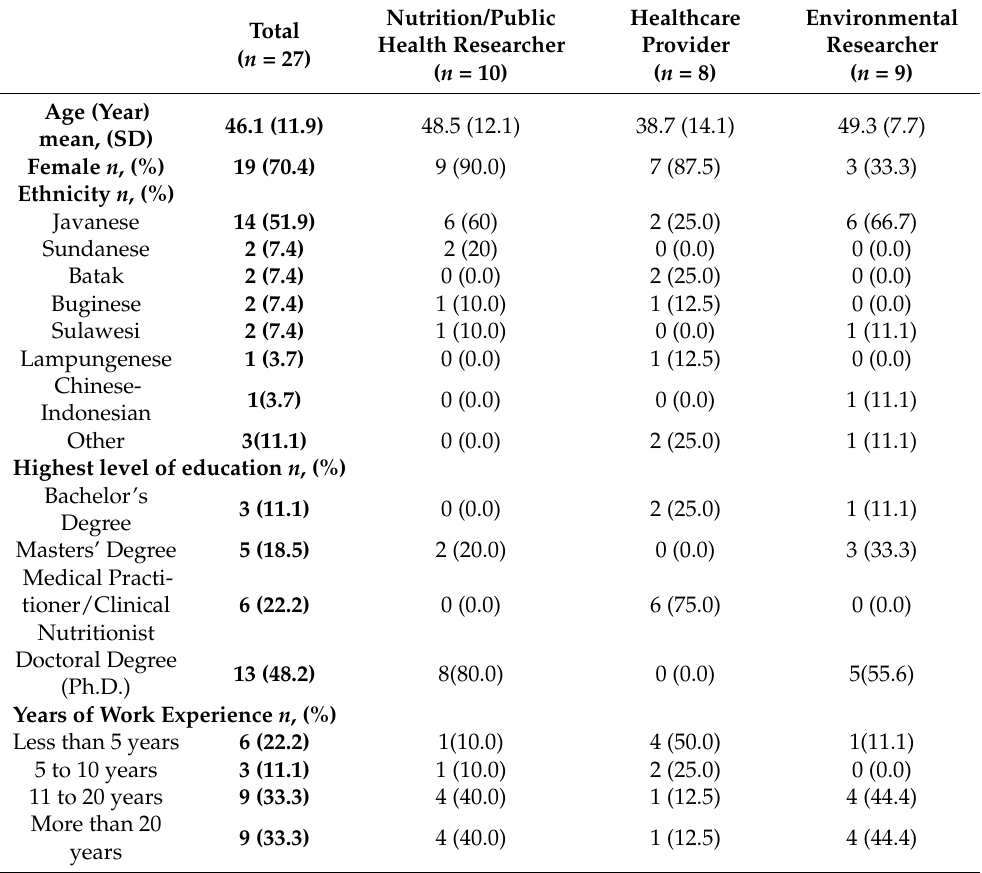
Table 3. Demographic Characteristics of Study